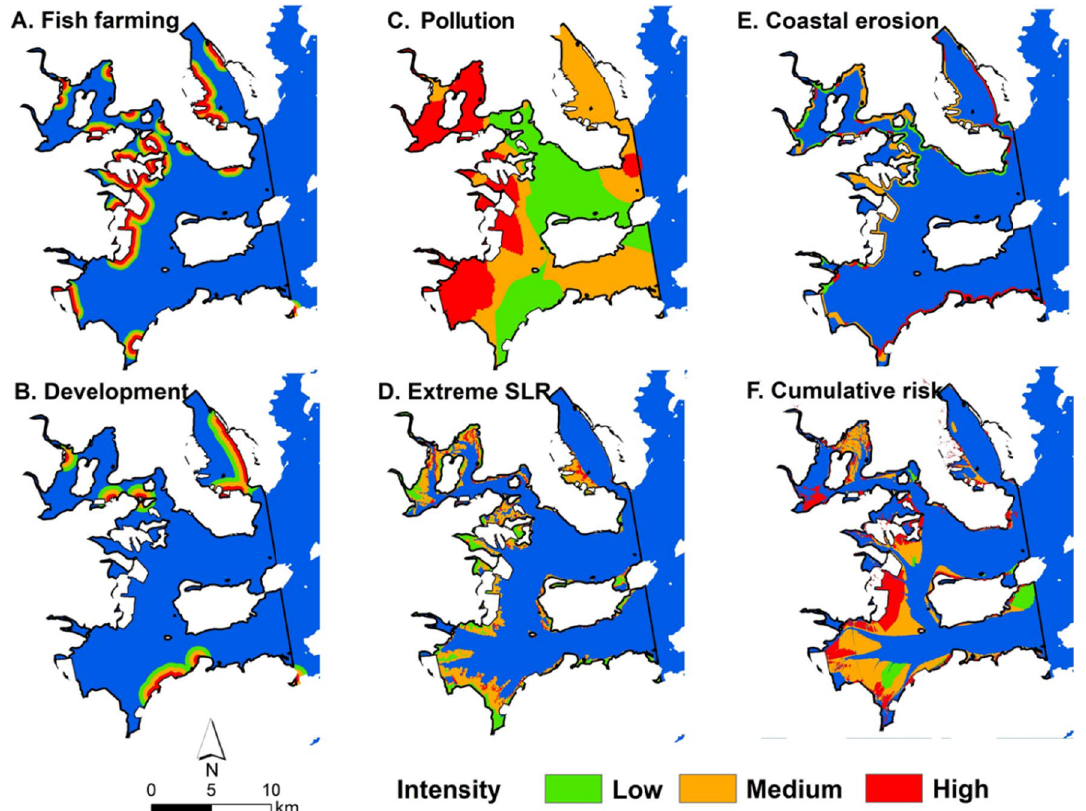
Fig. 5 Intensity and spatial distributions of five stressors in Sansha Bay: A fish farming (reclaimed by aquaculture ponds), B development (reclaimed by impervious surface), C pollution, D extreme SLR, E coastal erosion, and F cumulative